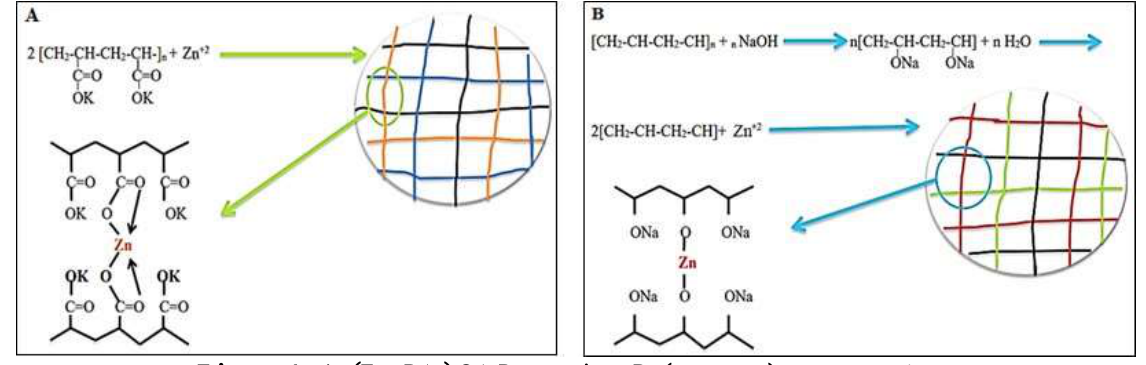
Figure 1: A (Zn-PA) SAP reaction, B (Zn-PVA) SAPs